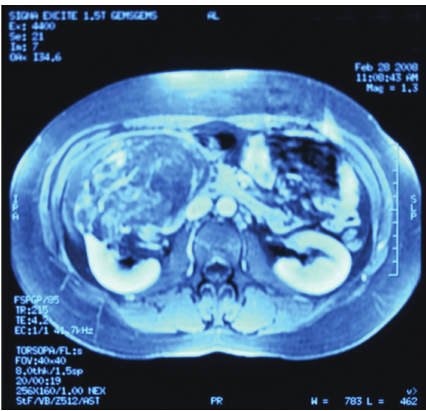
Figure 1: MRI showing a right retroperitoneal mass.